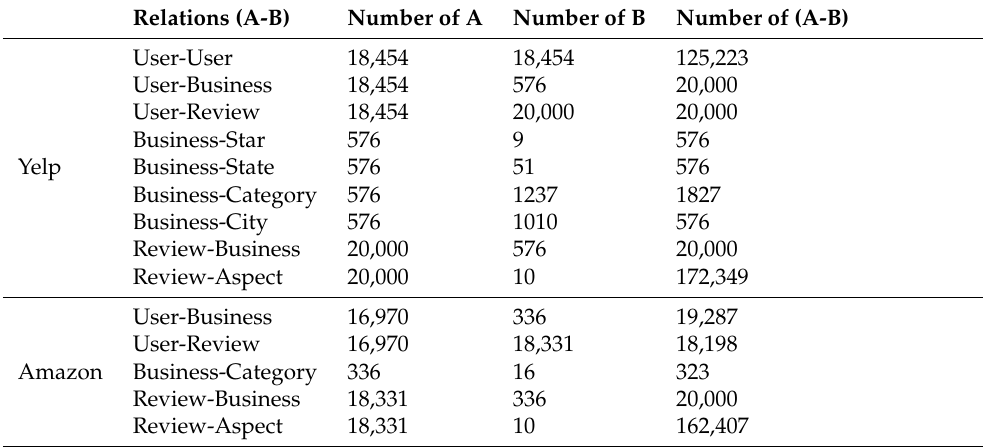
Table 3. Statistical information of the dataset.